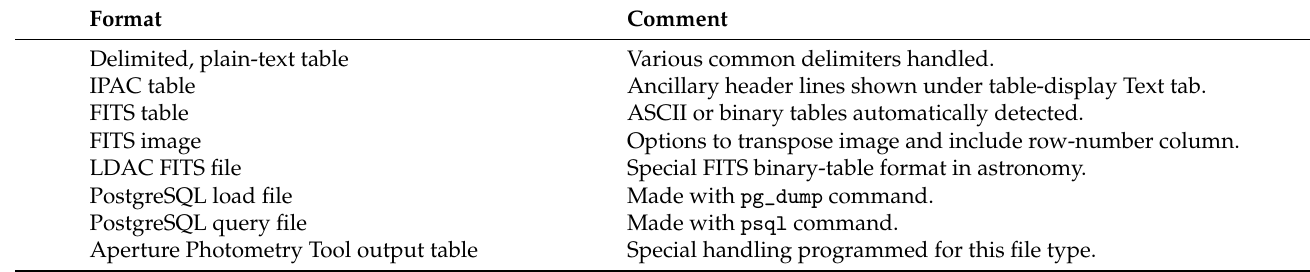
Table 2. File formats importable by Thoth (includes common and specialized formats). Format Comment Delimited, plain-text table Various common delimiters handled. Ancillary header lines shown under table-display Text tab. ASCII or binary tables automatically detected. FITS image Options to transpose image and include row-number column. LDAC FITS file Special FITS binary-table format in astronomy. PostgreSQL load file Made with pg_dump command. PostgreSQL query file Made with psql